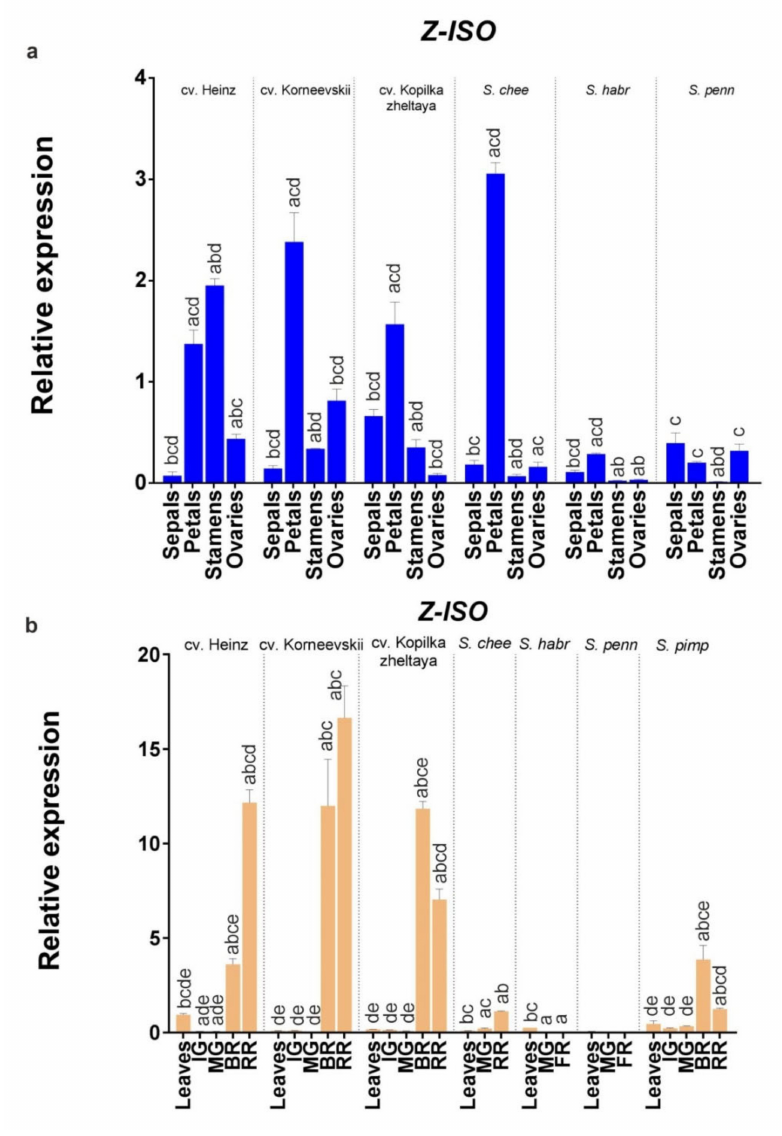
Figure 7. Comparison of Z-ISO mRNA expression in cultivars and wild species. ( a ) Flower organs; ( b ) leaves and fruit (IG, MG, BR, and RR or fully ripe [FR] stages). S. lycopersicum cultivars (Heinz, Korneevskii, and Kopilka zheltaya), S. cheesmaniae LA0421, S. habrochaites LA2144, and S. pennellii LA0716 were analyzed. The data were normalized to Expressed and Actin mRNA levels and presented as the mean ± SE ( n = 3). Different low-case letters above the bars indicate statistically significant differences ( p < 0.005) between gene expression levels in the tissues of one